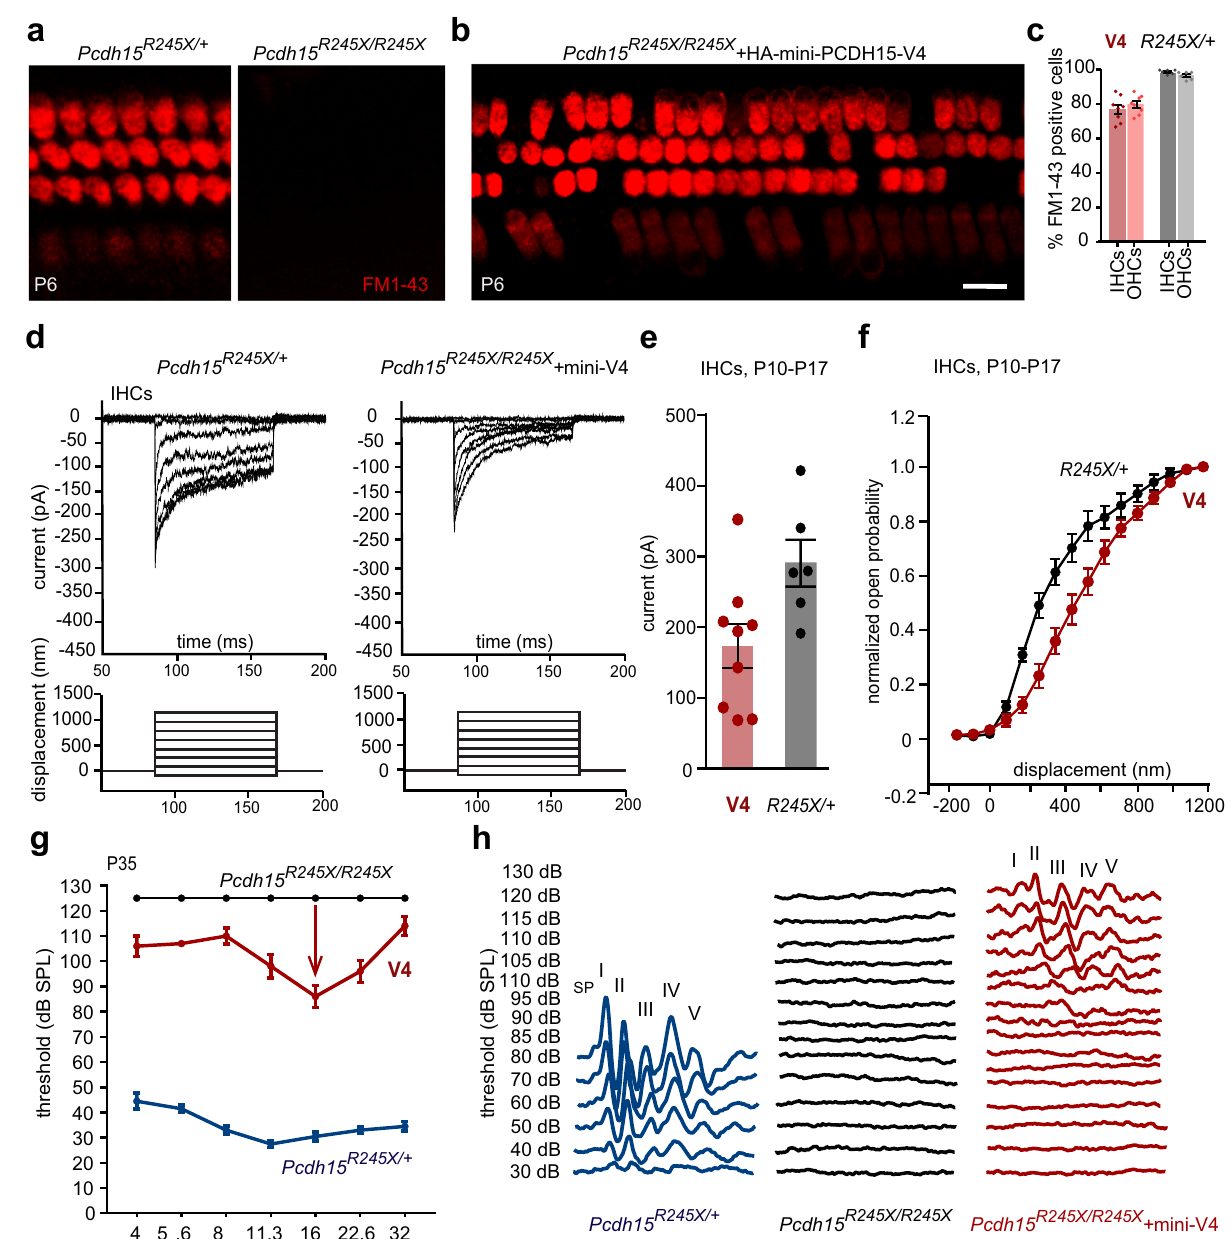
Fig.8|DeliveryofAAV-mini-PCDH15-V4rescuesmechanotransductionandthe ABR in Pcdh15 R245X/R245X mice. a Representative confocal microscopy images of FM1-43 dye loading in inner hair cells (IHCs) and outer hair cells (OHCs) from the middle region of the cochlea at P6. Pcdh15 R245X/+ mice (left), uninjected Pcdh15 R245X/R245X (right). b FM1-43 dye loading in Pcdh15 R245X/R245X knockout mice injected with AAV-mini-PCDH15-V4. Loading was restored in most hair cells. c Average percentage of IHCs and OHCs loaded with FM1-43; knockout mice injected with AAV-mini-PCDH15-V4 (red, n =8), uninjected Pcdh15 R245X/+ normal control mice (gray, n =6). About 80% of knockout cells loaded after treatment. d Representative transduction currents measured at P10-P17 (top) in response to − 175 to 1135-nm bundle de fl ections (bottom). A Pcdh15 R245X/+ hearing control IHC (left); a Pcdh15 R245X/R245X knockout IHC expressing mini-PCDH15-V4 (right). e Peak